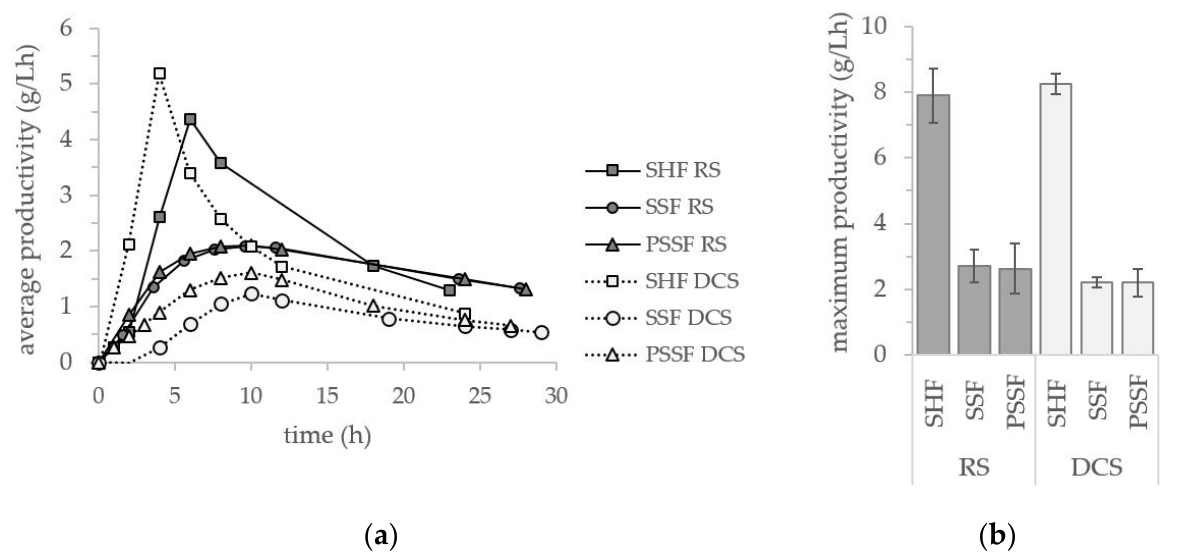
Figure 4. Productivity of B. coagulans 14-300 in SHF (52 °C and pH 6), SSF and PSSF (50 °C and pH 5) fermentation of RS- and DCS-LX substrate: ( a ) average productivity, ( b ) maximum productivity.